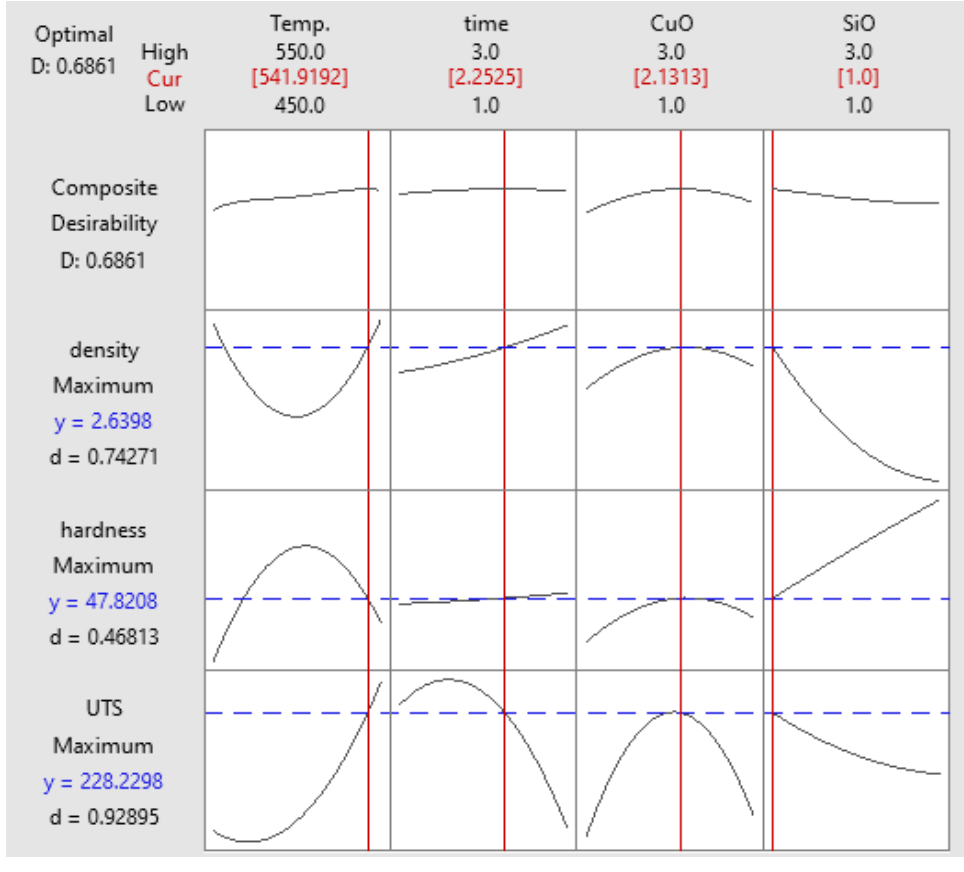
Figure 17. UTS, microhardness and density. Table 11. The confirmation tests details.